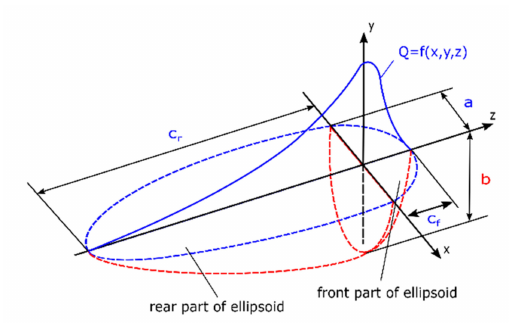
Figure 2. Double ellipsoid heat source models